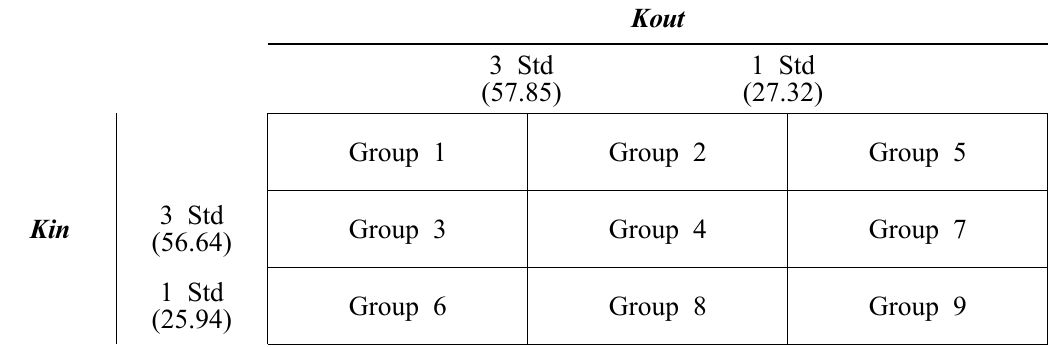
<Figure 2> Characterization of